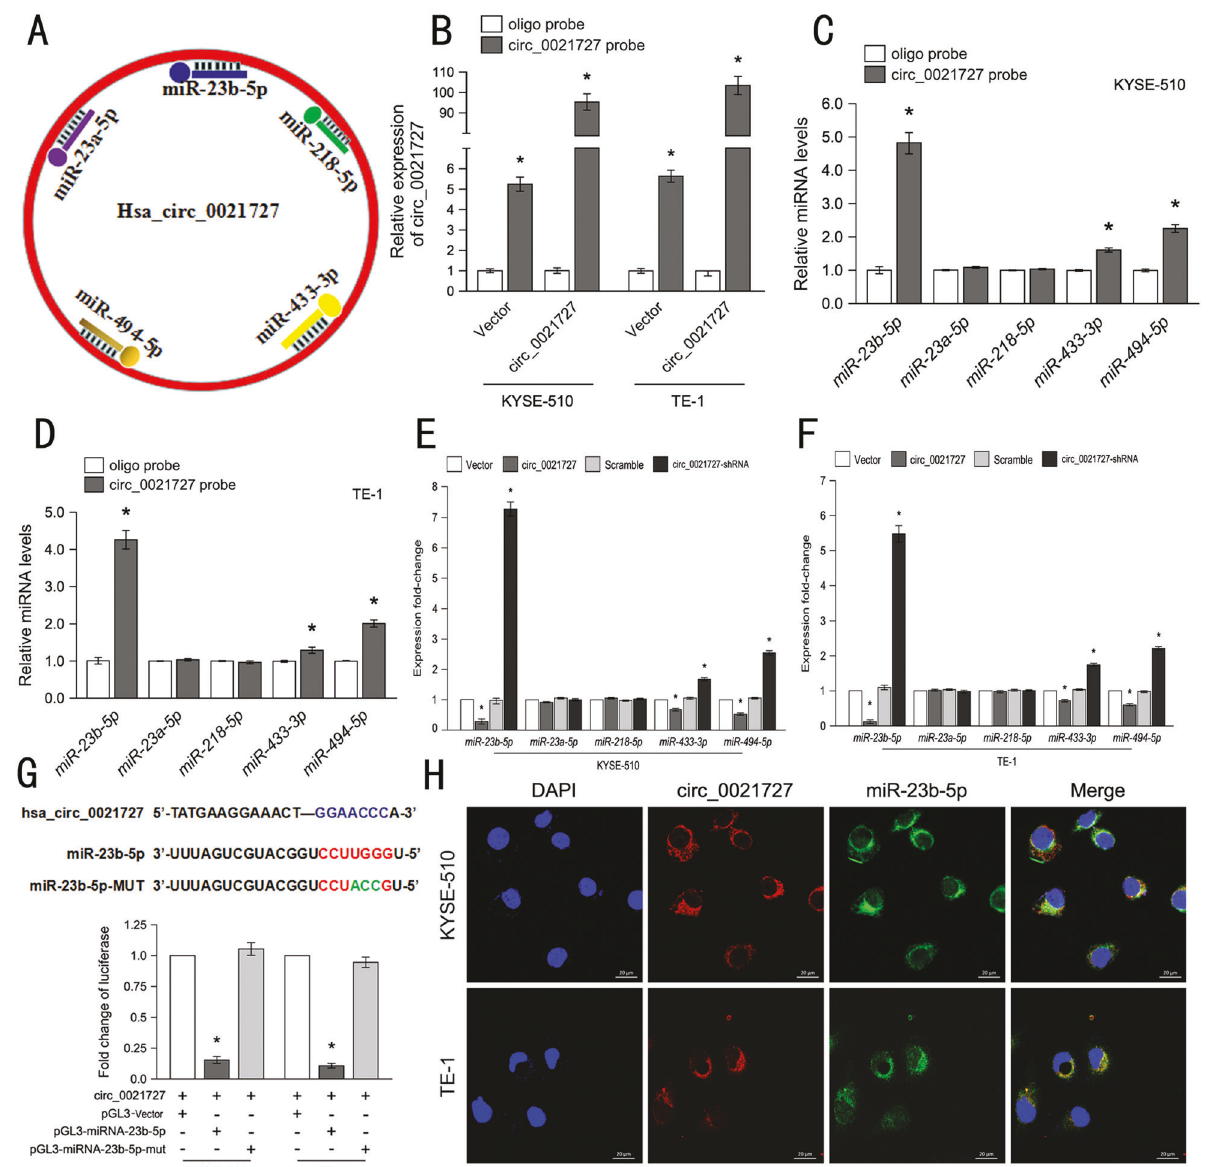
Fig. 4 Hsa_circ_0021727 functions as a sponge for miR-23b-5p. A Image suggesting that hsa_circ_0021727 might target bound miRNAs. B Probe ef fi ciency for qRT-PCR detection. C and D Relative levels of fi ve miRNAs in KYSE510 and TE-1 cells lysates pulled down by the hsa_circ_0021727 probe or the oligo probe. E and F qRT-PCR detection of the levels of fi ve miRNAs in KYSE510 and TE-1 cells transfected with hsa_circ_0021727 overexpression or knockdown lentiviral vectors. G A luciferase reporter gene assay performed in KYSE510 and TE-1 cells co- transfected with hsa_circ_0021727 overexpression vector, pGL3 plasmid, pGL3-miR-23b-5p-wt, and pGL3-miR-23b-5p-mut. H FISH analysis showing the colocalization between hsa_circ_0021727 and miR-23b-5p in KYSE510 and TE-1 cells. Values are expressed as the means ± SD; * P <